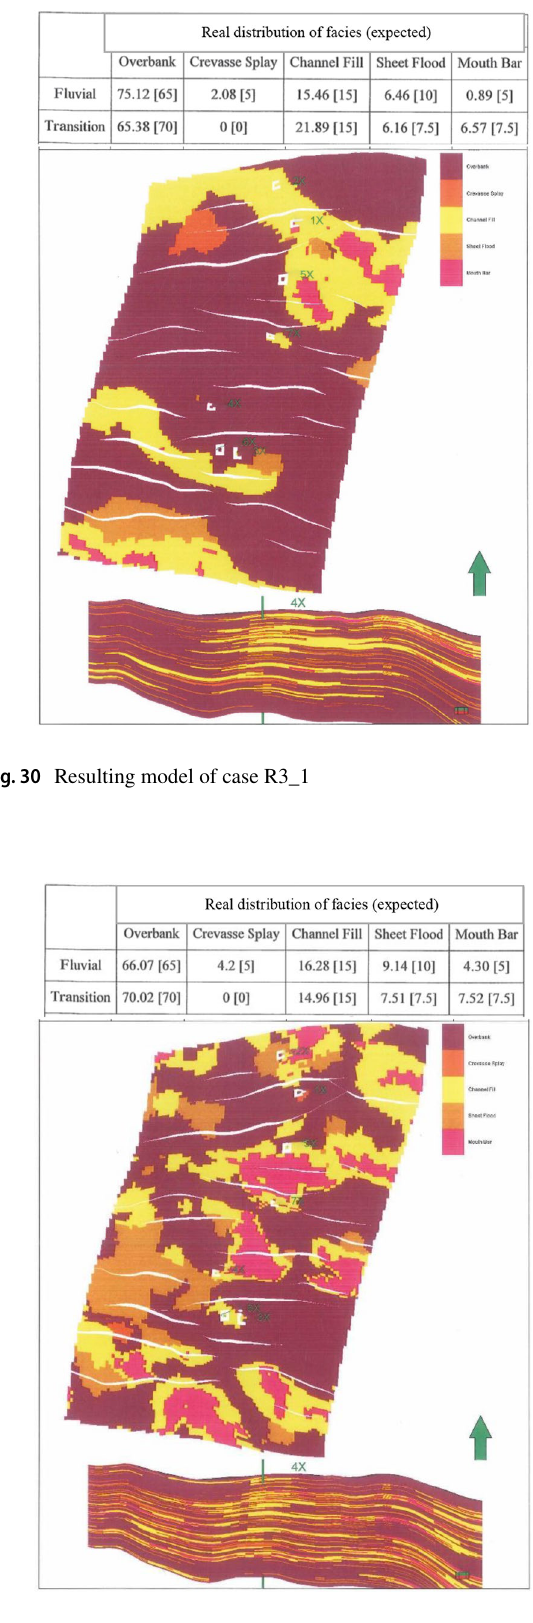
Fig. 29 Resulting model of case R2_3